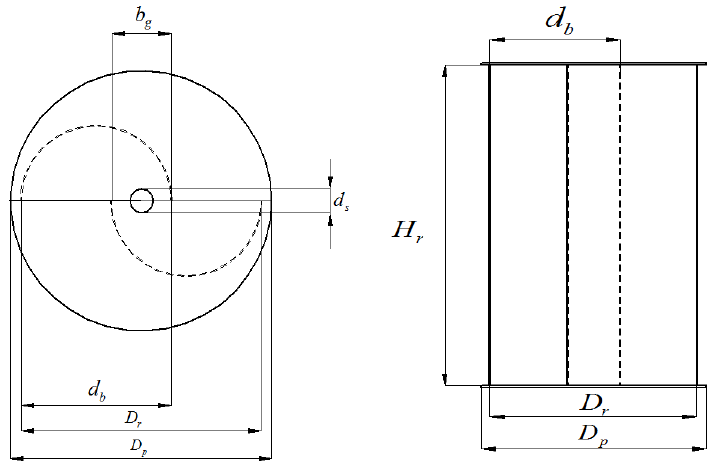
Figure 1. Design elements of the Savonius classic rotor.